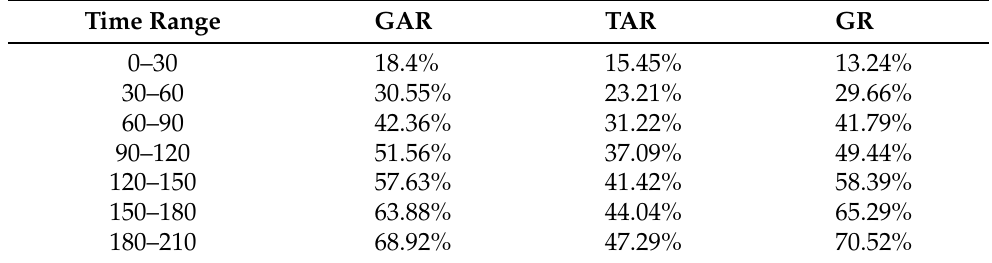
Table 8. Cumulative percentages of responses received per time range (in minutes).